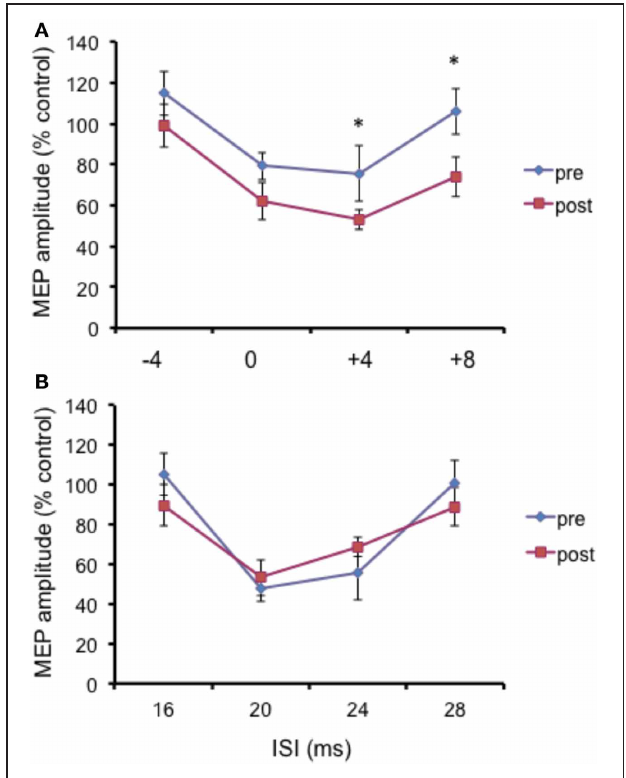
FIGURE 3 | Effects of cerebellar cTBS on SLAI (A) and SICI (B) in AD patients. Error bars indicate standard deviations. The size of MEPs is expressed as a percentage of the MEP evoked by magnetic stimulation alone. Error bars indicate mean standard errors.